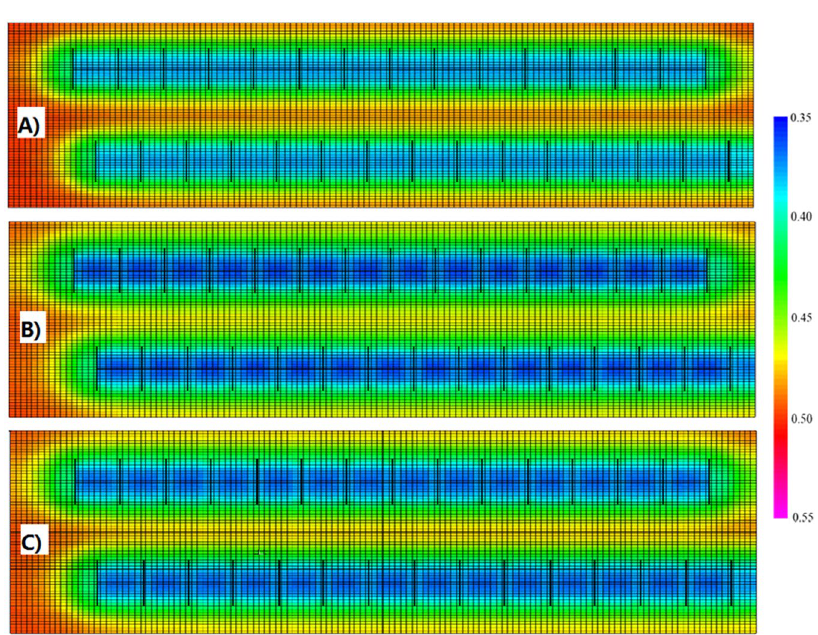
Figure 10. The oil saturation at the end of production for three cases. ( A ) Case A. ( B ) Case B. ( C ) Case